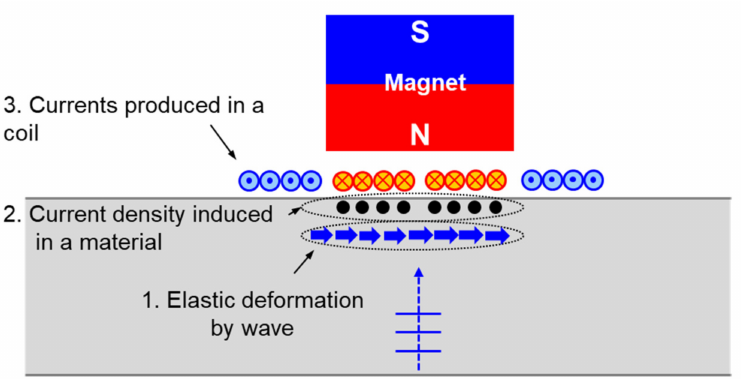
Figure 6. Ultrasonic wave receiving mechanism of the EMAT used in the